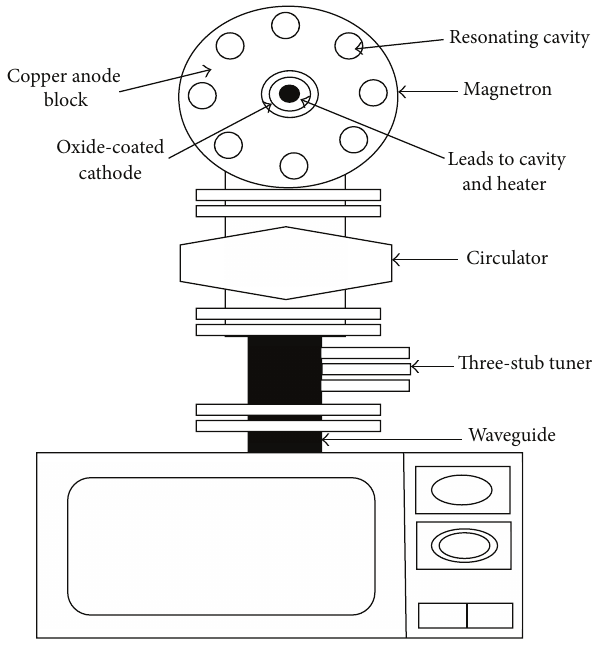
Figure 5: Schematic drawing of microwave equipment (modified from [68]).